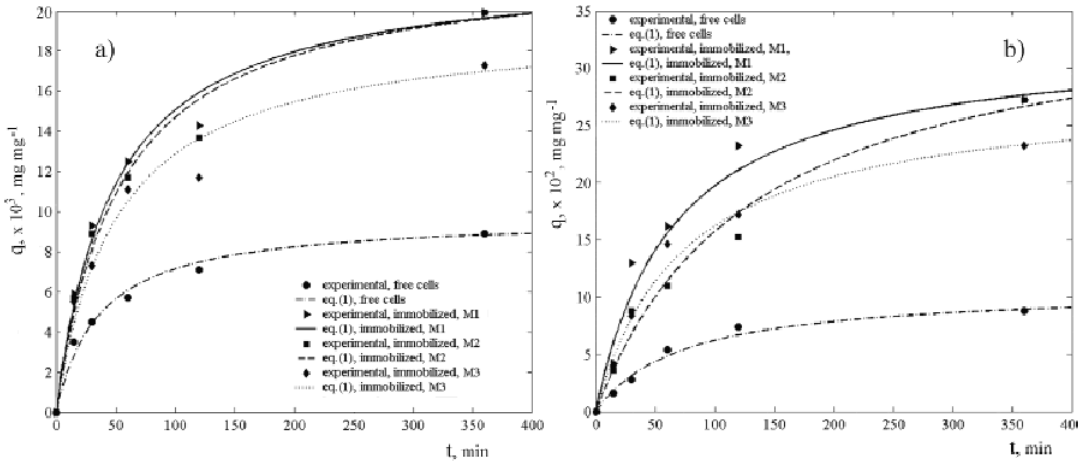
Figure 4. Metal ion adsorption by free and immobilized Tr. cutaneum R57 cells; (a) copper, (b)